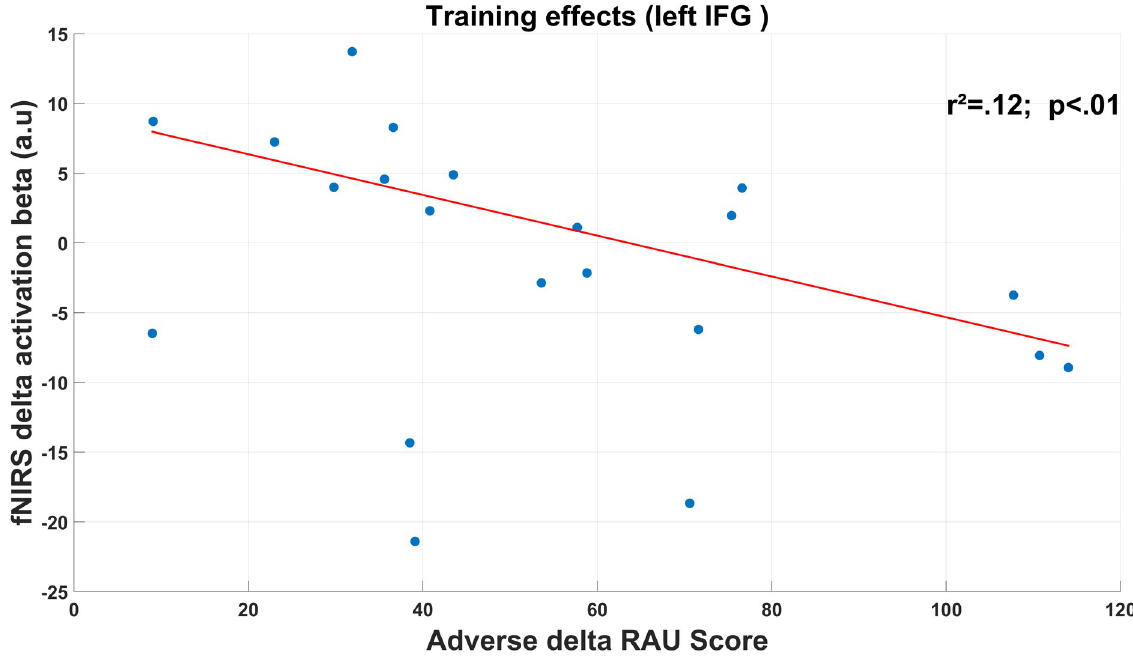
Fig 9. Relationship (robust regression) between training effects over the speech intelligibility (RAU score) in the adverse condition, and training effects over the left IFG activity (fNIRS activation). For both measures, the delta corresponds to the difference between Post- training and Pre-training session